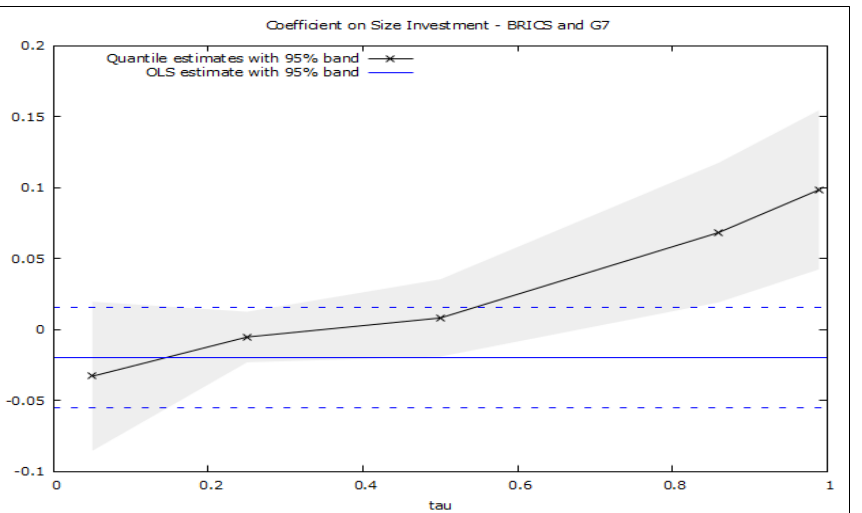
Figure 1. Performance of the SMB INV risk factor on the percentiles and conditional average of the GDP growth rate of the BRICS and G7 countries.